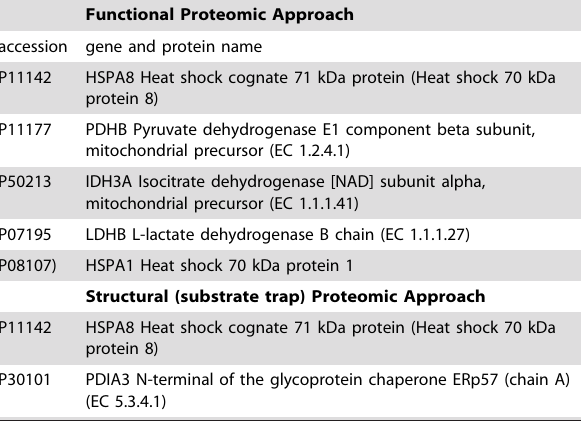
Functional Proteomic Approach